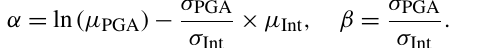
cremental dynamic analysis, dynamic history analysis,